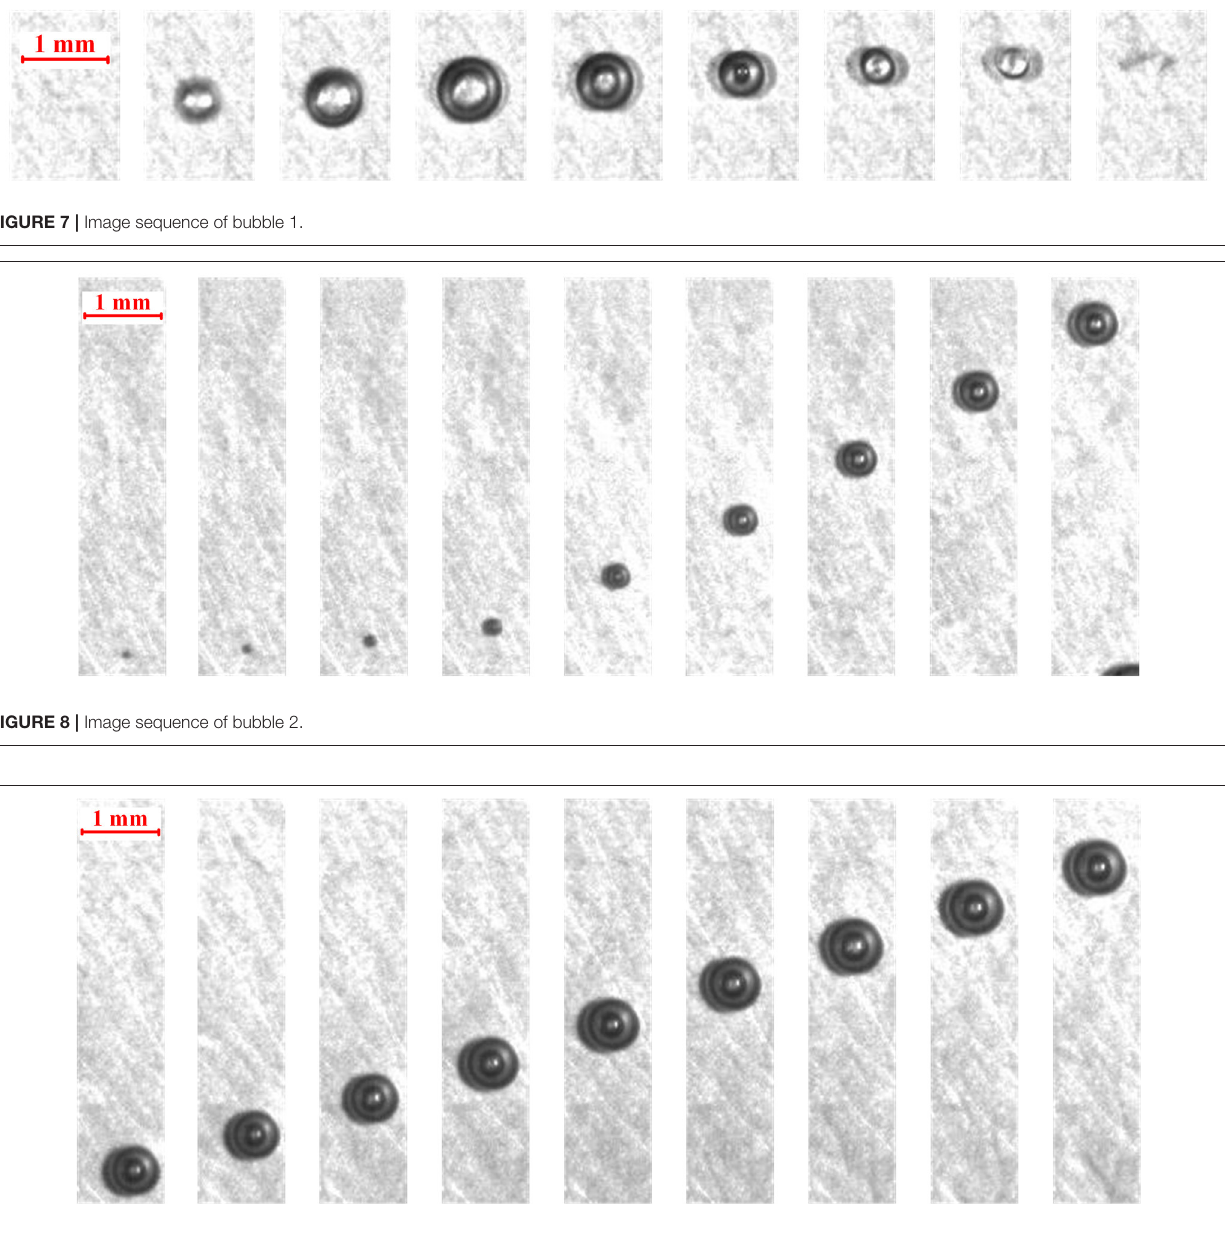
FIGURE 9 | Image sequence of bubble